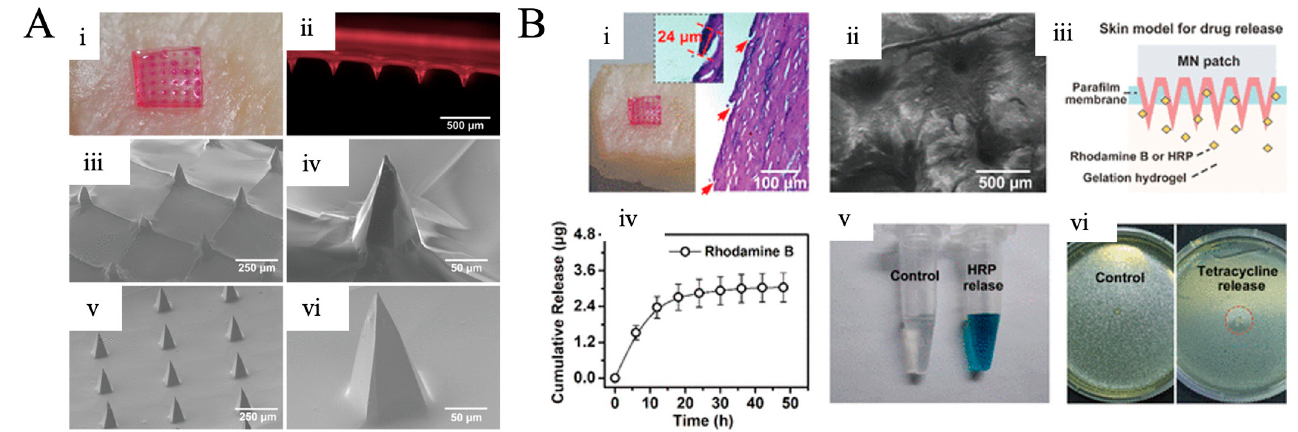
Figure 5. ( A , B ) Silk MN patches for transdermal delivery. ( A ) Silk fibroin microneedle patch morphology. (i) A drug-loaded silk fibroin MNP with Rhodamine B dyed covering pig skin. (ii) An image of SF MNP under the bright field. SEM images of (iii,iv) SF MNP and (v,vi) double layer SF MNP. ( B ) The two-layered SF MNP is used as drug carrier and is implanted into the skin. (i,ii) SF MN patch implemented to pig skin: (i) image and histological segment displaying the penetration sites of MNPs, and (ii) SEM image of pig skin that has been pierced. (iii) Schematical representation of HRP and Rhodamine B release from the skin model. (iv) The total amount of rhodamine B discharged from a SF MNP. (v) HRP bioactivity in a hydrogel produced from an SF MNP. (vi) Inhibition zone of E. coli with antibiotic-loaded SF MNPs. Reprinted with permission from [107], copyright 2021 American Chemical Society.